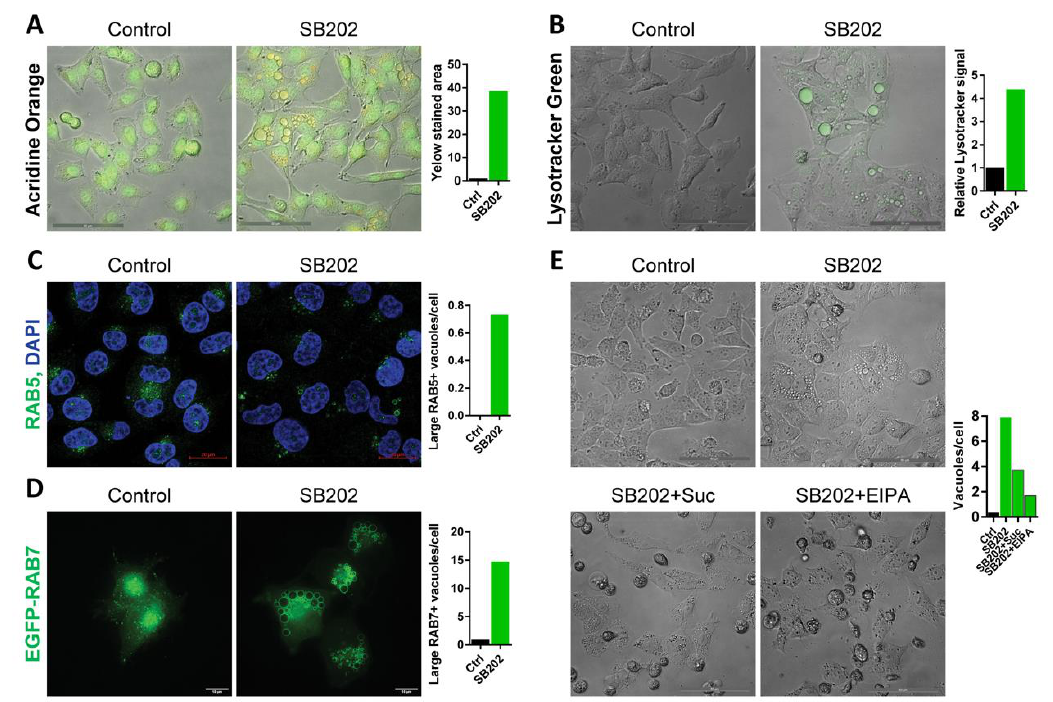
Figure 3. Vacuole-like vesicles induced by pyridinyl imidazole compounds in melanoma cells have an endolysosomal origin. A375 cells were treated with SB202190 (SB202; 15 μM) or the equivalent amount of vehicle (DMSO) in control. ( A ) Cells were treated with SB202190 for 20 h and stained with acridine orange (5 µg/mL) for 15 min. Scale bar: 50 µm. The graph shows the relative change in the yellow stained area in response to SB202190. Similar results were obtained in two independent experiments. ( B ) Cells were treated with SB202190 for 20 h and stained with LysoTracker Green (50 nM) for 15 min. Scale bar: 50 µm. The graph shows the relative change of the LysoTracker Green signal in response to SB202190. Similar results were obtained in two independent experiments. ( C ) The confocal microscopy detection of endogenous early endosomal marker RAB5 after 24 h treatment with SB202190. Scale bar: 20 µm. The graph shows the number of RAB5-positive vacuoles per cell with a diameter larger than 1 µm. Similar results were obtained in three independent experiments. ( D ) Deconvolved wide-field fluorescence microscopy imaging of EGFP-tagged late endosomal/lysosomal marker RAB7A after 24 h SB202190 treatment. Scale bar: 10 µm. The diameter